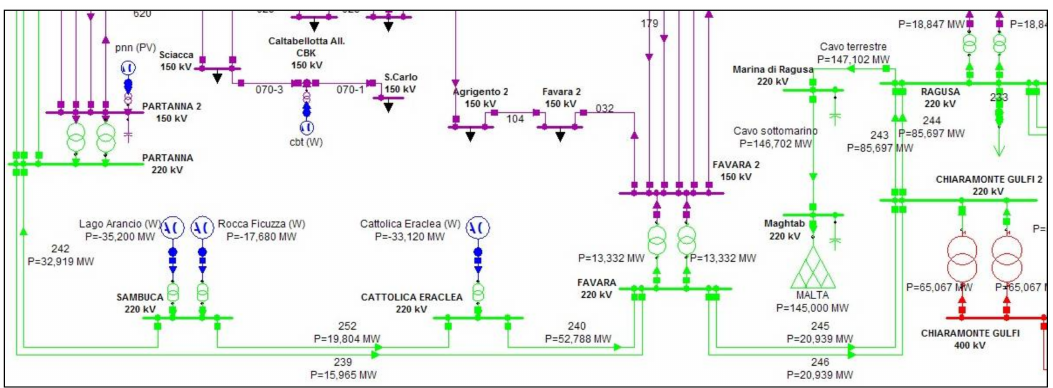
Figure 3. Scenario 1—Power flows on the portion of the network near the submarine interconnection connected to Ragusa station.